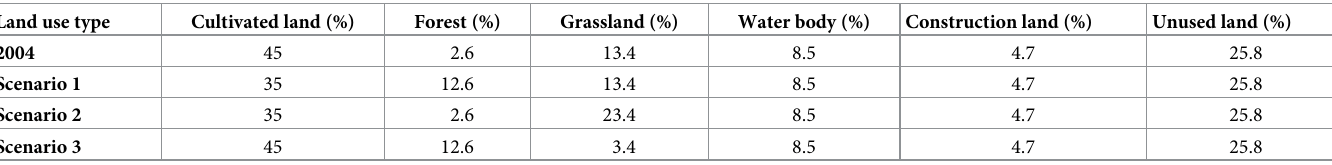
Table 2. Land use area of various scenarios in the